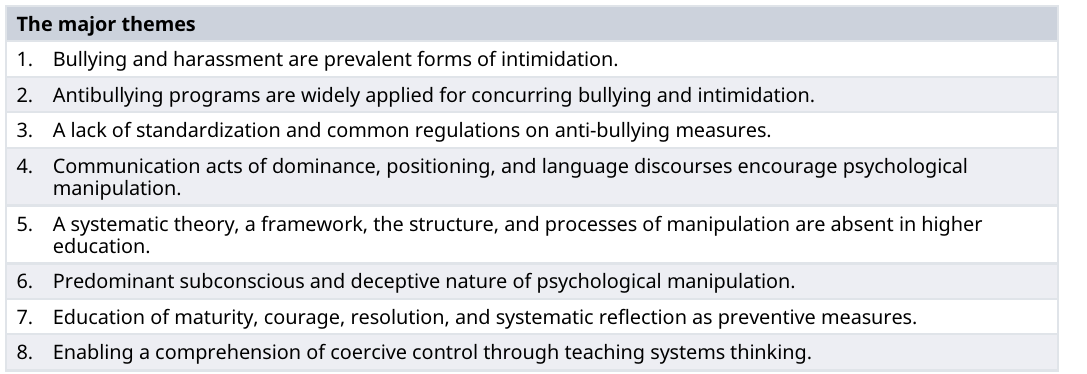
Table 1. The results of documentary analysis of textual data. The major